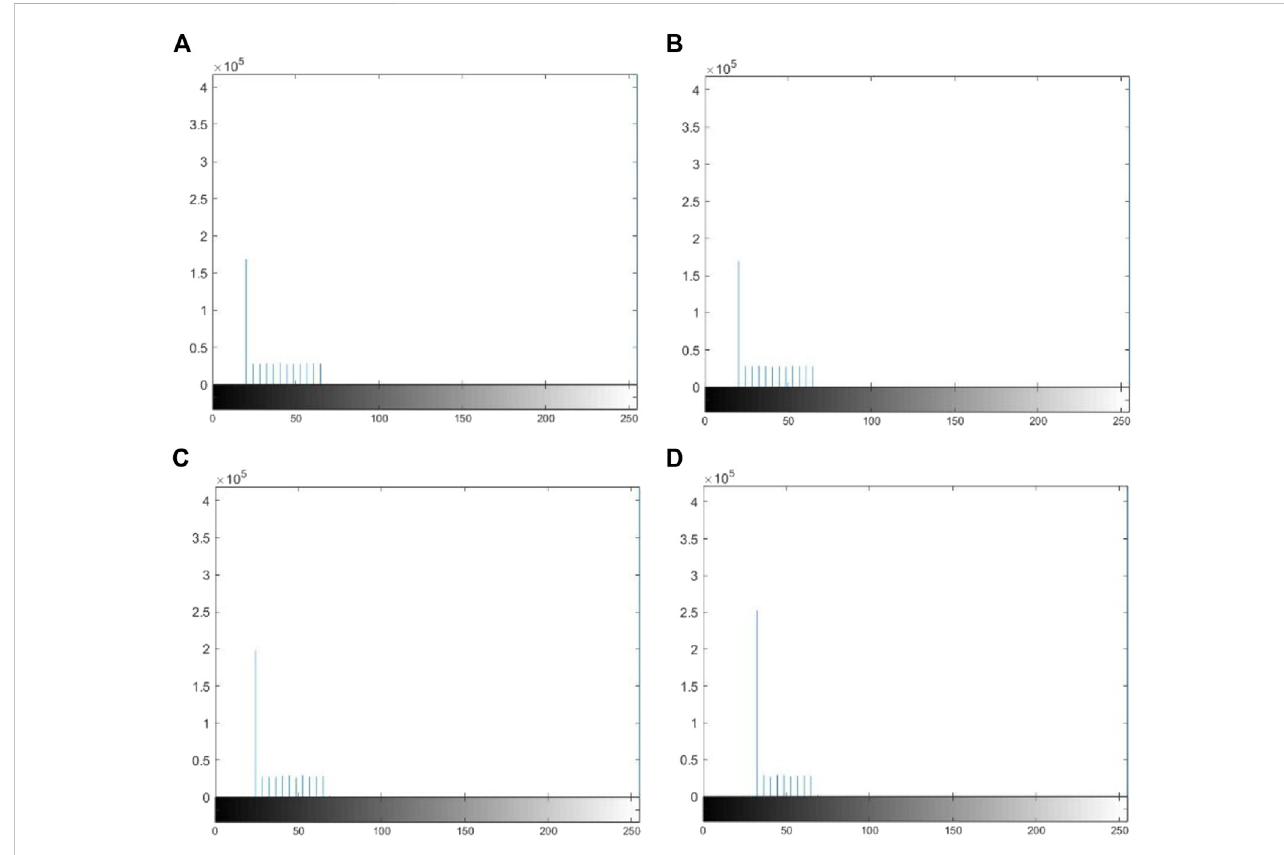
FIGURE 21 Histograms of reconstruction results: (A) without phase removal, (B) TFDM, (C) LSM and (D) PRM.